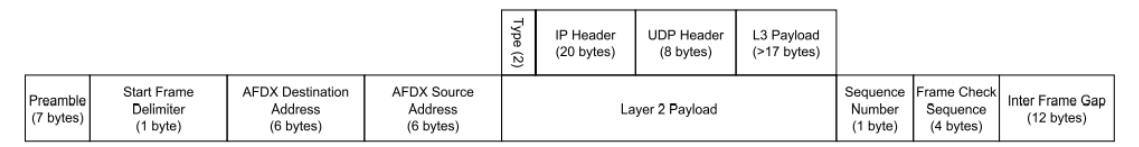
Figure 2. ARINC 664 frame